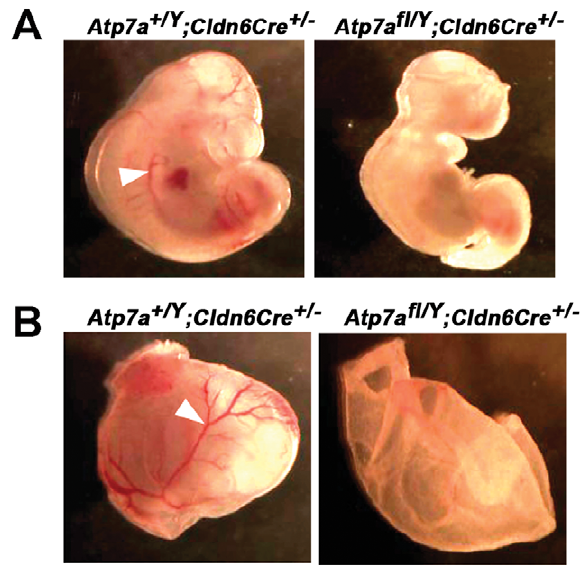
Figure 4. Morphological and vascular abnormalities in male hemizygous Atp7a fl/Y ; Clnd6Cre + / 2 embryos. A) Developmental anomalies particularly in the frontonasal region and tail bud orientation were apparent in the Atp7a fl/Y ; Cldn6Cre + / 2 embryos at E10.5. B) The blood-filled vascular network observed in wild type embryos and yolk sacs (arrowheads) was lacking for the Atp7a fl/Y ; Cldn6Cre + / 2